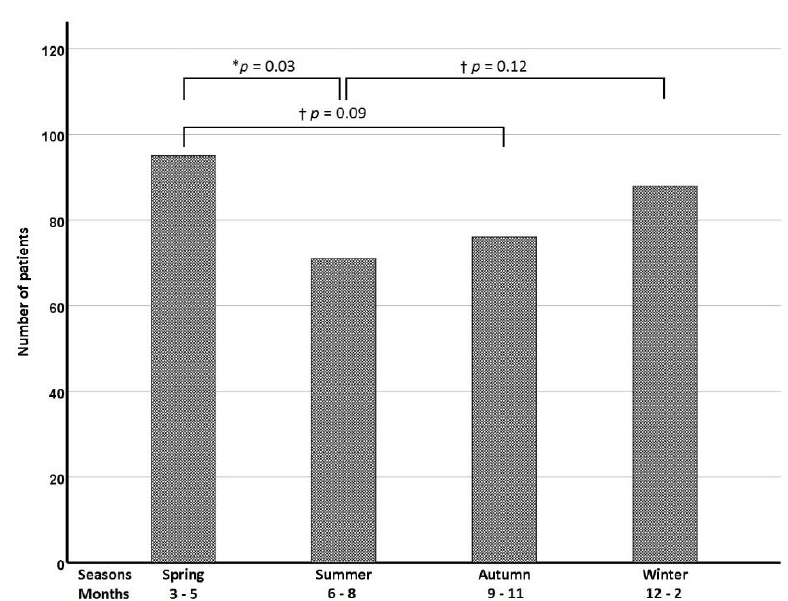
Figure 1. Seasonal and monthly distributions in patients with cranial nerve zoster. * p < 0.05, z test; † p > 0.05, z test.